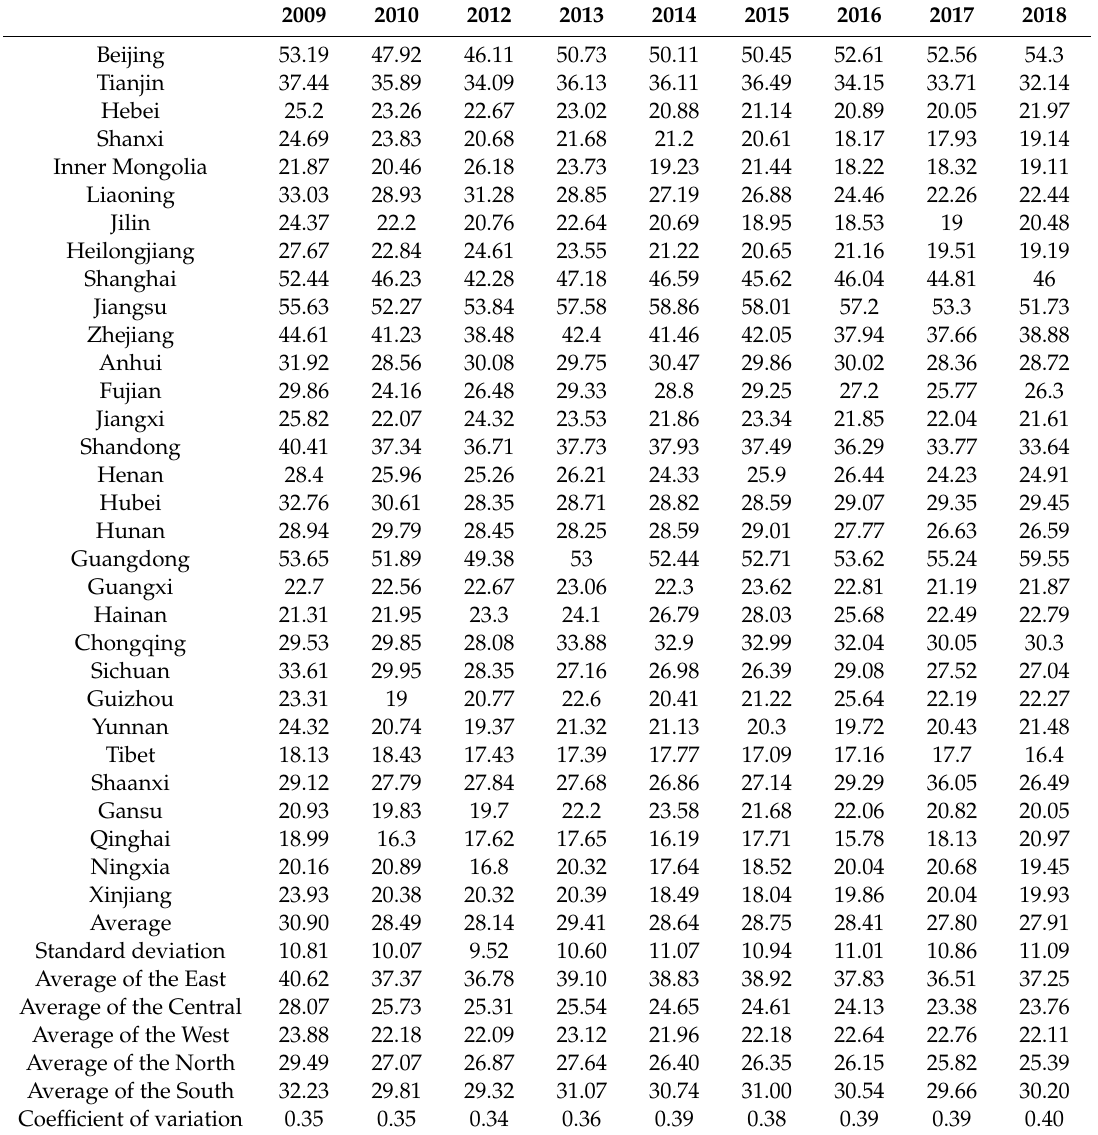
Table 2. Regional innovation index of provinces and cities in